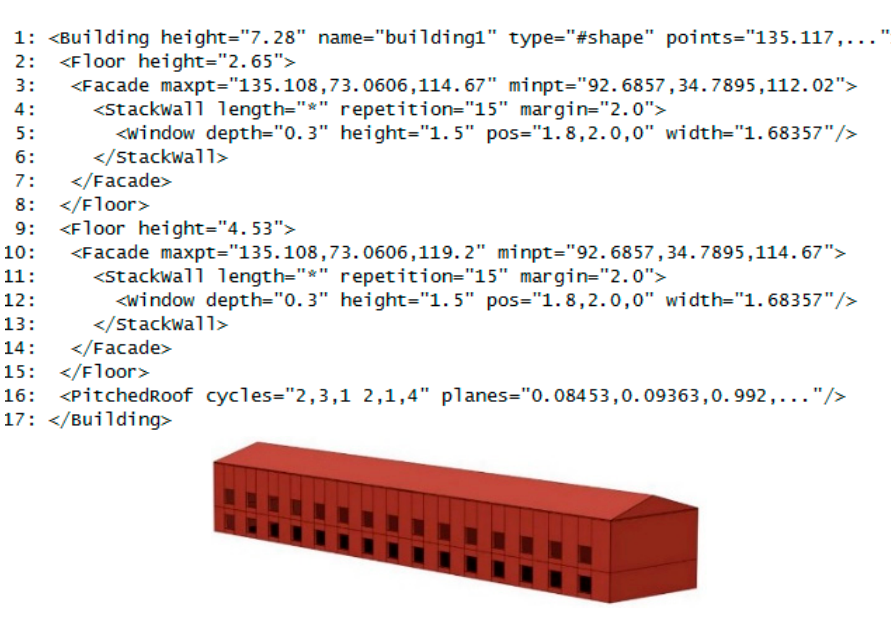
Figure 4. A two-storied building described by XBML code.